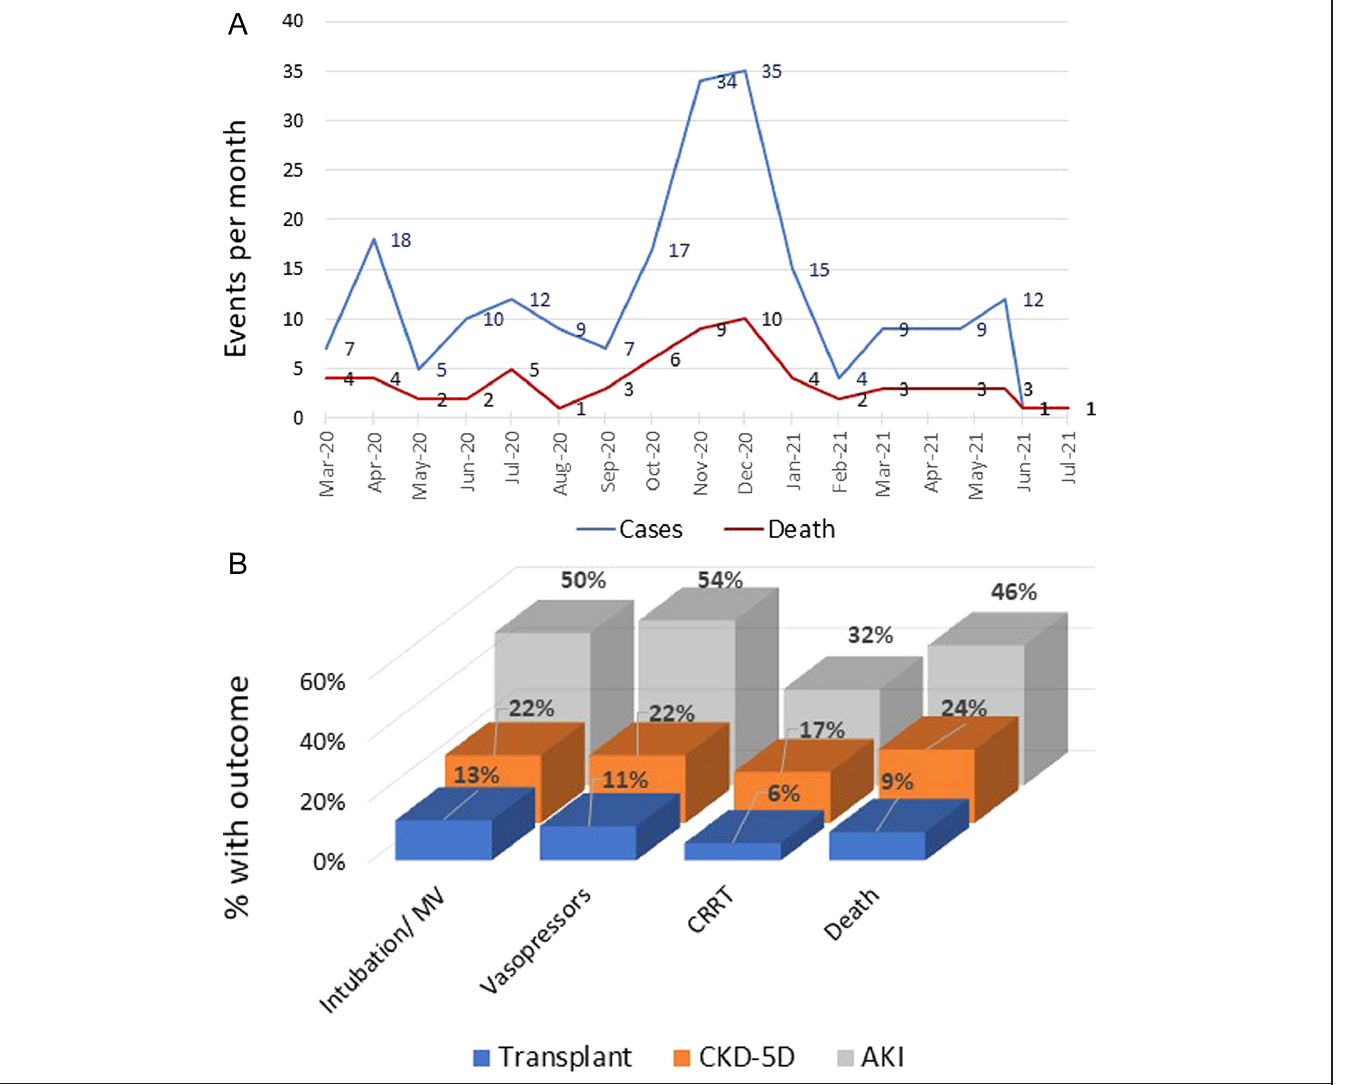
Figure 1. (A) Monthly rates of hospitalized kidney patients with COVID-19 and in-hospital mortality. (B) Clinical outcomes of hospitalized kidney patients with COVID-19. AKI, acute kidney injury; CKD-5D, chronic kidney disease stage 5 on chronic dialysis; CRRT, continuous renal replacement therapy; MV, mechanical